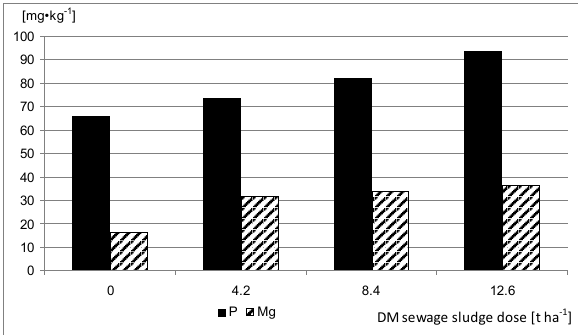
Figure 1: The effect of a growing dose of communal sewage sludge on available phosphorous and magnesium in